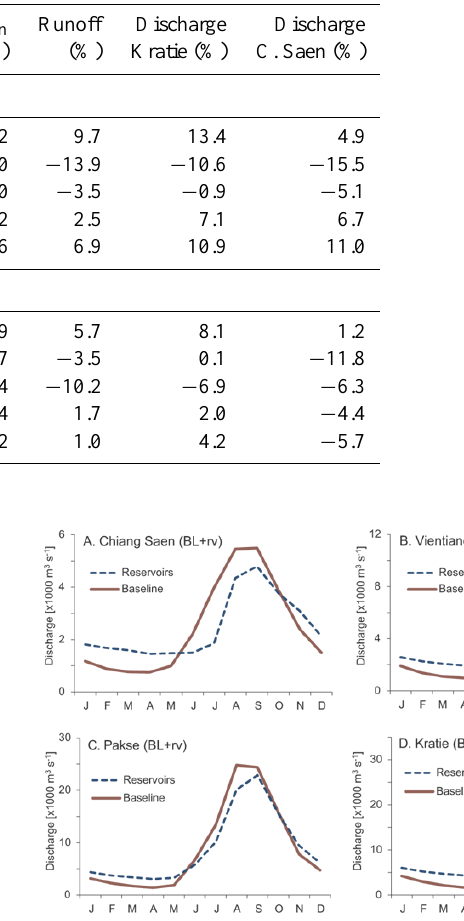
Fig. 4. Impact of climate change on Mekong main river discharge. Monthly average discharges of the model runs under emission sce- narios (2032–2042) compared to baseline (1982–1992). (A) Chi- ang Saen under A1b emission scenario; (B) Chiang Saen under B1 emission scenario; (C) Kratie under A1b emission scenario; and (D) Kratie under B1 emission scenario. See Tables S2 and S3 in the Supplement for tabulated data. Note the differing discharge scales.